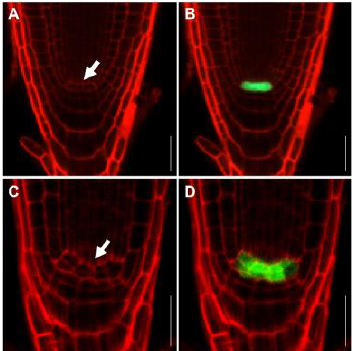
Figure 5. FB1 induces QC cells divided. ( A , B ) Expression pattern of WOX5::ERGFP (green) in wild- type seedling. ( C , D ) Expression pattern of WOX5::ERGFP (green) in wild-type seedling grown in half- strength MS containing 0.5 μM FB1 for 9 days. The root tips were stained with PI (red). The arrowhead in ( A , C ) indicates the QC cells. Bars = 25 µm.